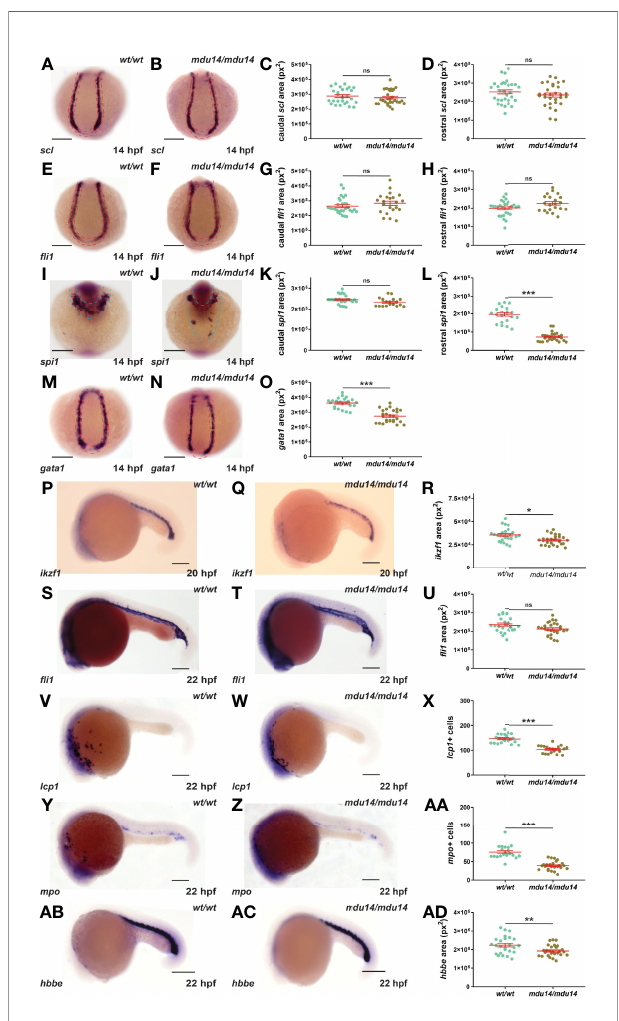
FIGURE 3 | Mutation of crlf3 impacts primitive hematopoiesis. (A – AD) . Homozygous crlf3 wt/wt ( wt/wt ), and crlf3 mdu14/mdu14 ( mdu14/mdu14 ) embryos were subjected to WISH at 14 hpf with scl (A, B) , fl i1 (E, F) , spi1 (I, J) and gata1 (M, N) , at 20 hpf with ikzf1 (P, Q) , and at 22 hpf with fl i1 (S, T) , lcp1 (V, W) , mpo (Y, Z) and hbbe (AB, AC) (scale bar = 200 m m; red and blue dotted areas depict caudal and rostral expression domains, respectively). Individual embryos were assessed for area of staining or cell number at the indicated locations for scl (C, D) , fl i1 (G, H, U) , spi1 (K, L) , gata1 (O) , ikzf1 (R) , lcp1 (X) , mpo (AA) and hbbe (AD) , with the mean and SEM shown in red and level of statistical-signi fi cance indicated (*** p < 0.001, ** p < 0.01, * p < 0.05, ns, not signi fi cant). Welch ’ s correction was used for panel (R)